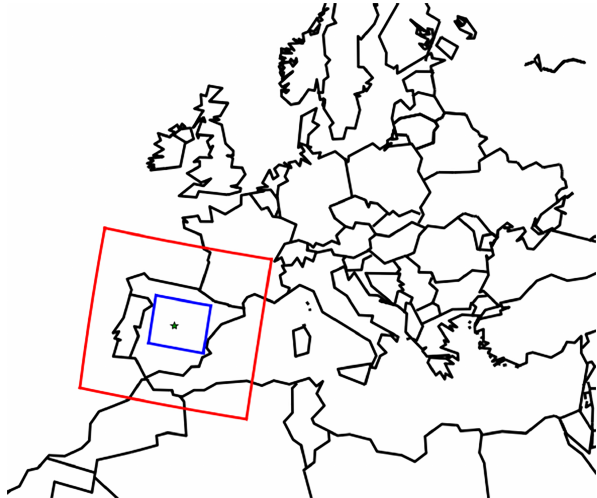
Figure 1. WRF domains d01 (red, 1500km × 1440km, resolu- tion: 30 × 30km 2 ) and d02 (blue, 490km × 430km, resolution: 10 × 10km 2 ). The location of Madrid is shown by a green